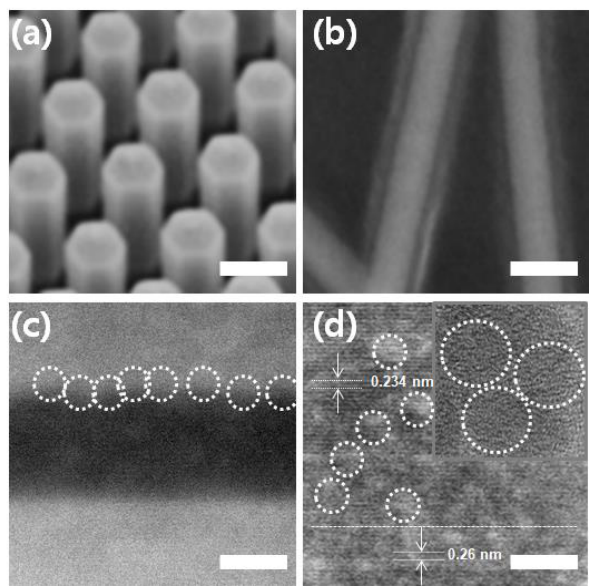
Figure 1. ( a ) Top view SEM images of the nanowires (NWs) of ZnO / TiO 2 , the scale bar indicates 1 µ m; ( b ) HR-TEM image of ZnO / TiO 2 core / shell NWs, the scale bar indicates 500 nm; ( c ) high magnification cross-sectional TEM images of the NWs with AgCl-doped CdSe quantum dot (QD) interlayer, the scale bar indicates 50 nm; ( d ) and a high-resolution TEM image (white circle) of QDs, the scale bar indicates 10 nm.